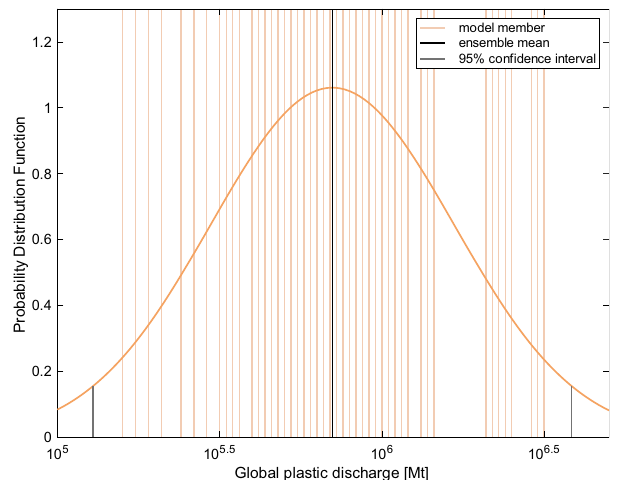
Fig. 4 | Optimized global plastic discharge (Mt, metric tons). The estimation is derivedfromathree-dimensionalvariationalmethodpoweredbyasuperensemble of model parameters and emission inventories. The thicker black line represents the ensemble mean with thinner orange ones for each member. The curve is the probability distribution function (pdf) of the optimized global plastic emissions, which is assumed to be a log-normal distribution based on the simulated surface plastic mass (Supplementary Fig. 2). The short gray vertical lines mark the 95% con fi denceinterval. The minimum and maximum discharges derived from models #52 and #51, which are not shown in the fi gure, are 10 2.9 and 10 7.0 Mt,